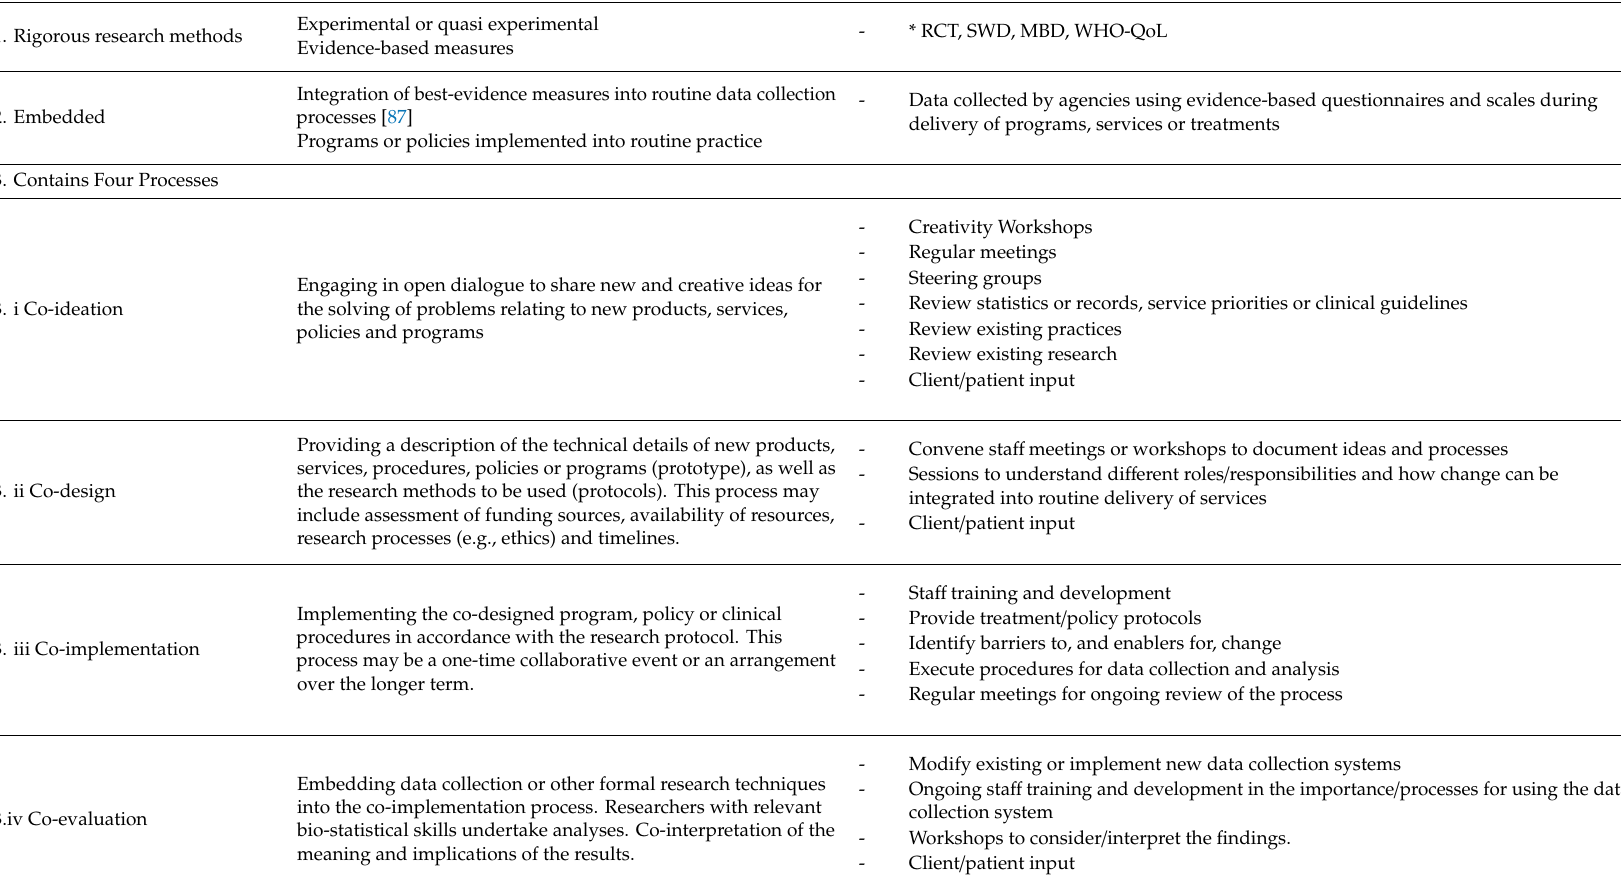
Table 4. Co-Creation of New Knowledge—Terminology and Operational